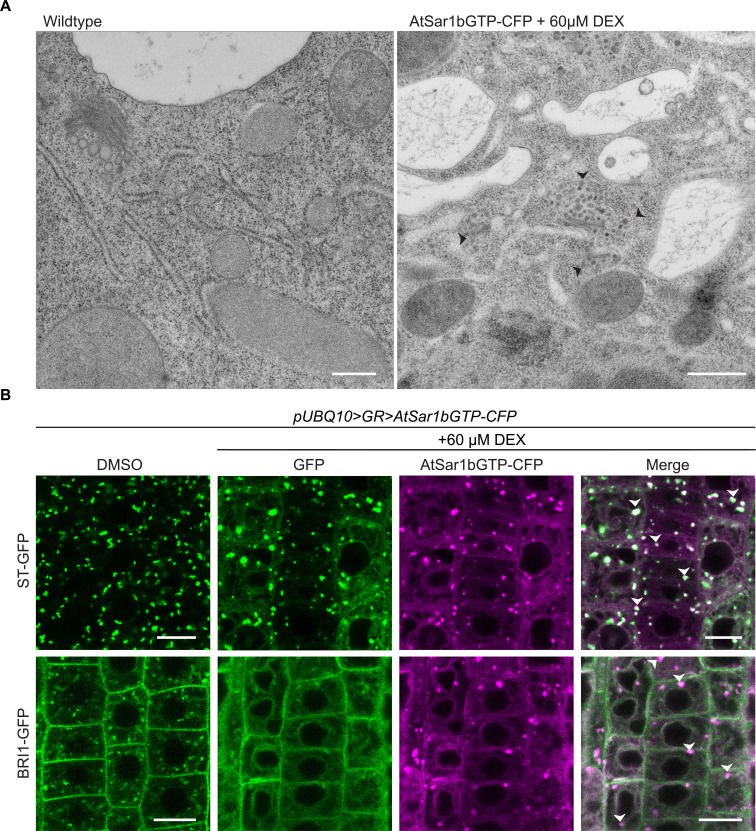
AtSar1b-GTP-CFP expression blocks the ER exit of secretory pathway proteins.(A) EM of high-pressure frozen Arabidopsis root tips. After 6 hr of induction with 60 µM DEX, AtSar1b-GTP-CFP expression causes bloating of the ER, aggregation of Golgi stacks and leads to an accumulation of vesicles in the cell (black arrows). Scale bars = 500 nm. (B) After 6 hr of induction with 60 µM DEX, AtSar1b-GTP-CFP is expressed. Both the Golgi targeted protein; ST-GFP and plasma membrane destined BRI1-GFP are retained at the ER when exit from the ER via COPII vesicles is blocked by expression of AtSar1b-GTP-CFP. Green and magenta pseudo colors indicate fluorescence from GFP and CFP respectively. Scale bars = 10 µm.